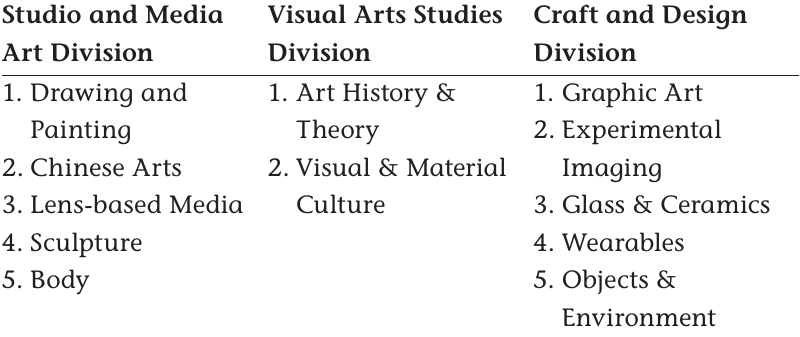
Figure 2: Clusters available for visual arts